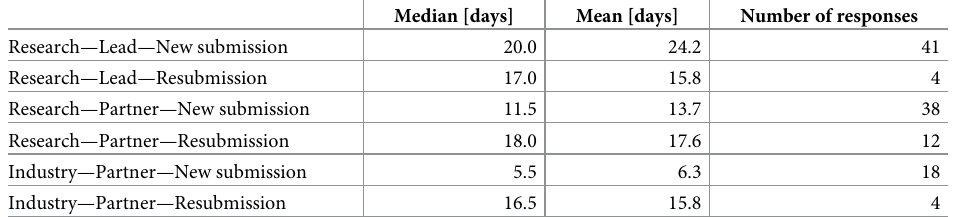
Table 4. Responses to the question “How much time in days did your organization spend working on the proposal overall (including your days)?” for different